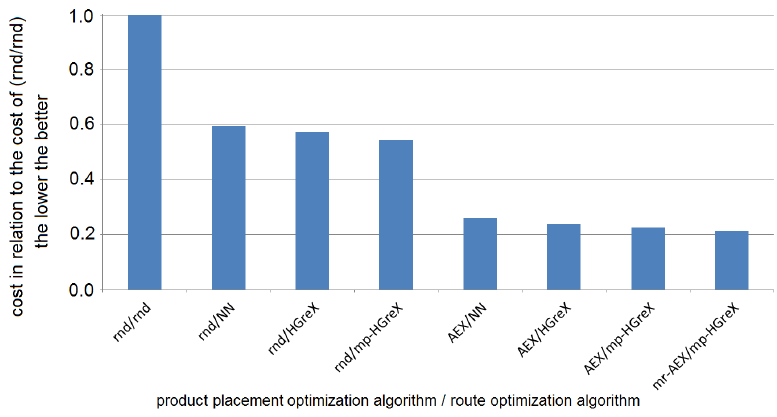
Figure 10. Comparison of the performance of the presented methods with various improvements (see Section 5.4). On horizontal axis: the optimization method. On vertical axis: the average obtained product placement cost (the lower the better) as percentage of the cost with the random product placement and random routes over the six warehouses with order lists presented in Table